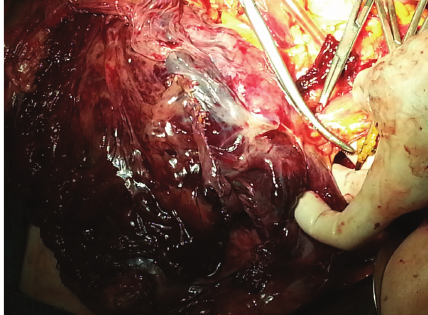
Figure 2: Intraoperative image: laparotomy shows a solid abdom- inal tumor clearly separated. The mass occupies most of the upper quadrants of the abdomen, originated from the